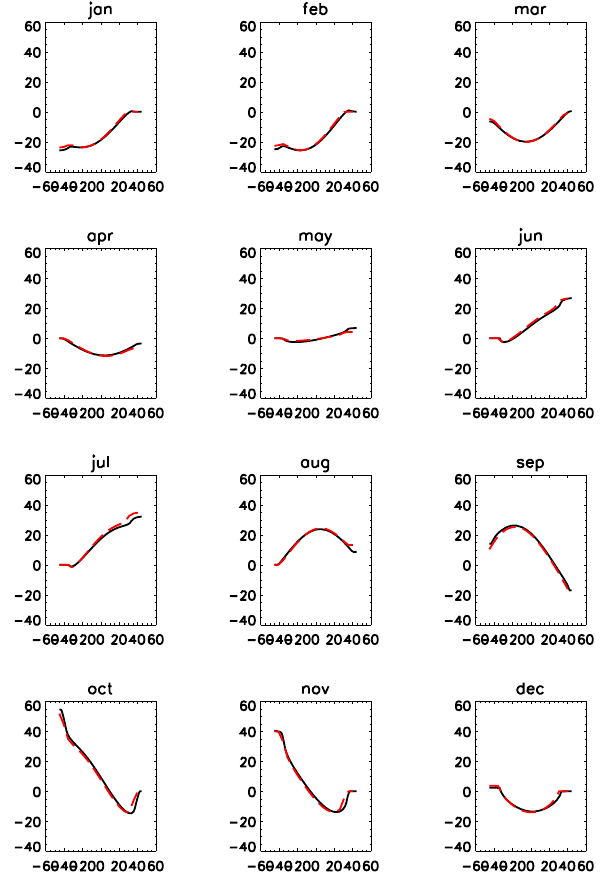
Fig. 15. Mid-Holocene changes in monthly TOA solar insolation relative to the present day, as a function of latitude as supplied by PMIP3 and calculated within HadGEM2-ES.